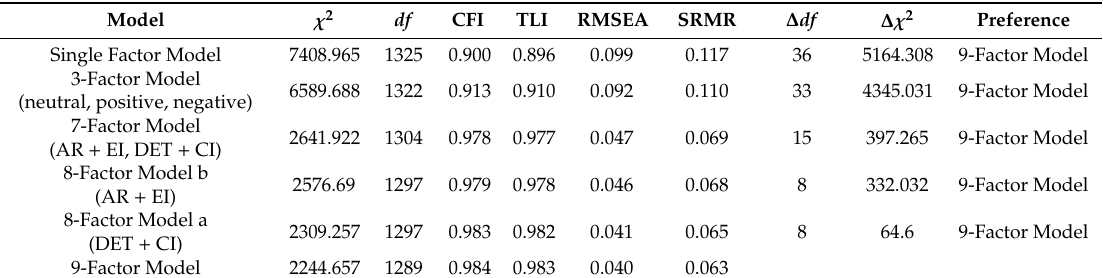
Figure 3. Focal 9-factor model and alternative models for examination of the factorial structure of work-related rumination and its concomitants. Table 4. Fit indices and χ 2 -difference test among alternative measurement models of work-related rumination and their concomitants.